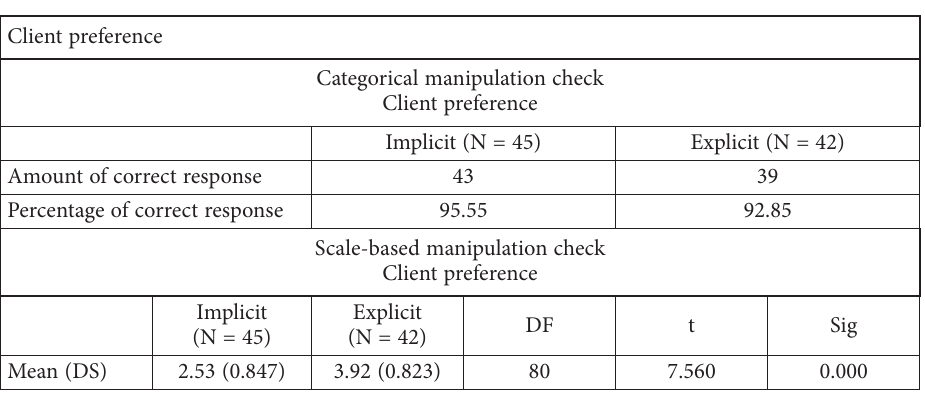
Table 1. Result of manipulation